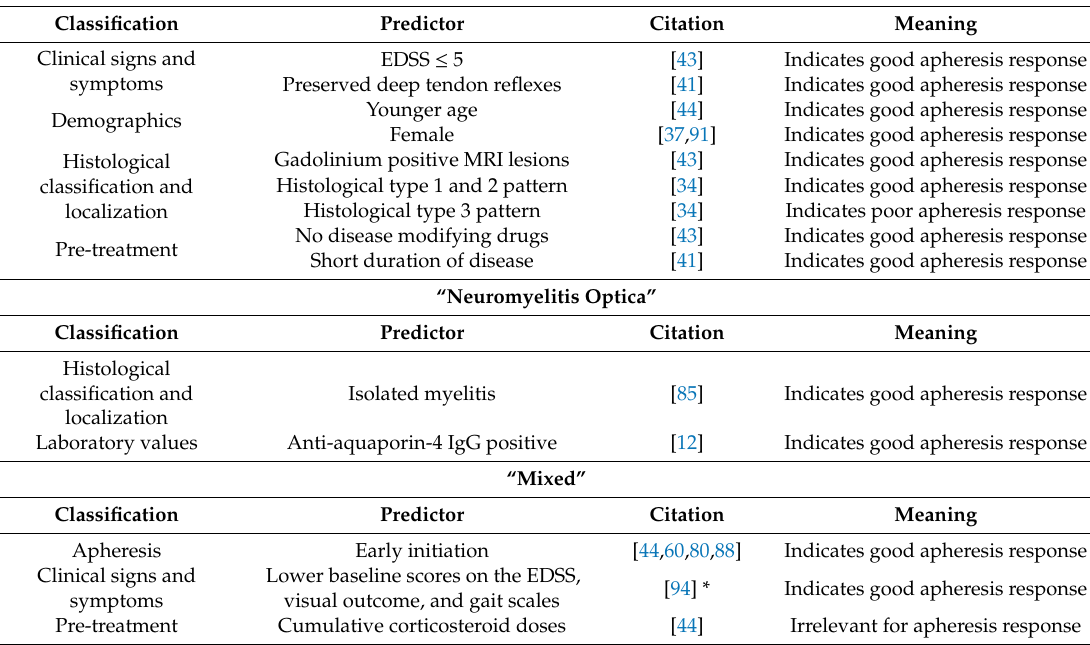
Table 3. Predictors of apheresis response. EDSS = Expanded Disability Status Scale; MRI = magnetic resonance imaging. * Pediatric patients